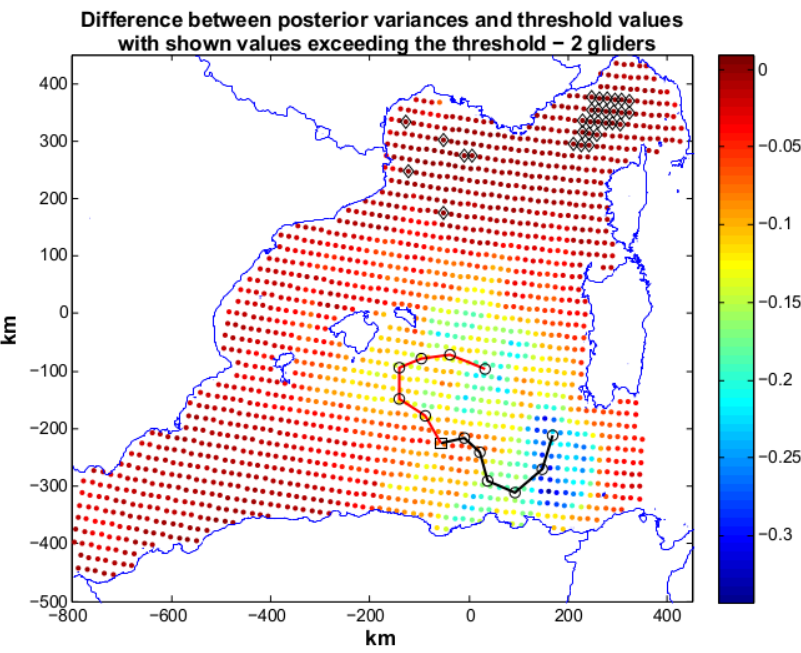
Figure 5. Scenario 1: planned paths for two gliders. The solution is characterized by J η = 0.0828 and J c = 2. In the figure we show also the difference between posterior variances and relative values of the objective threshold. Black markers toward the north-east part of the operation area indicate locations whose posterior was not lowered enough. These locations are limited in number proving the optimization produced a solution close to the optimum.